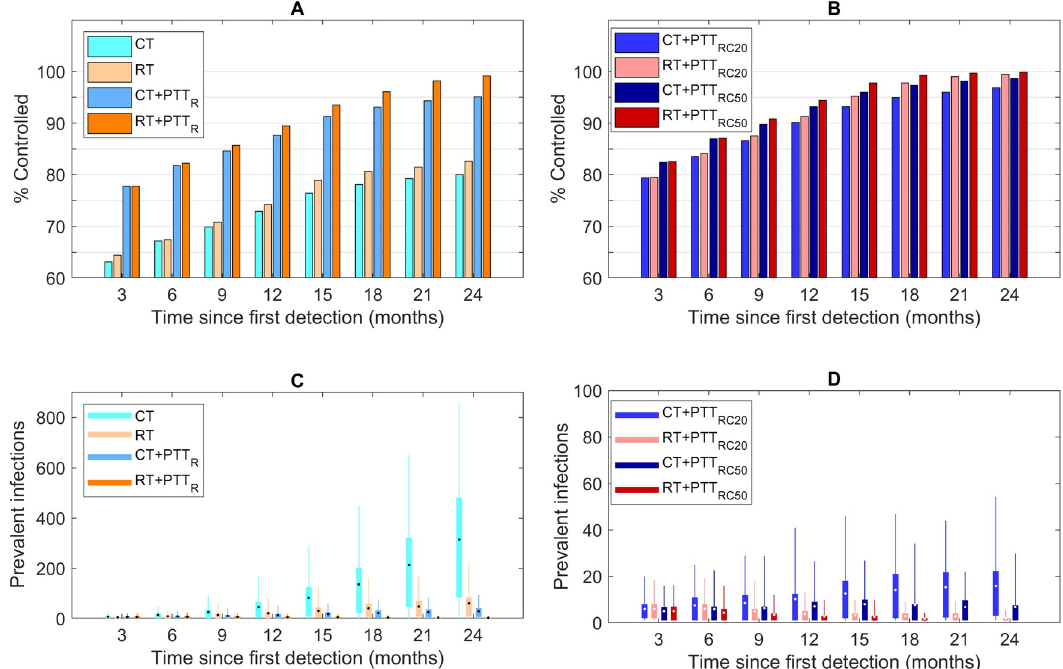
simulations as a function of time from the first detection and outbreak response strategy. The box denotes the interquartile range (25% to 75%), the whiskers the quantile (5% to 95%), the horizontal line in each box the median, and the dot in each box the mean. Outbreak size is the number or infected individuals at each time point for simulations in which the imported strain